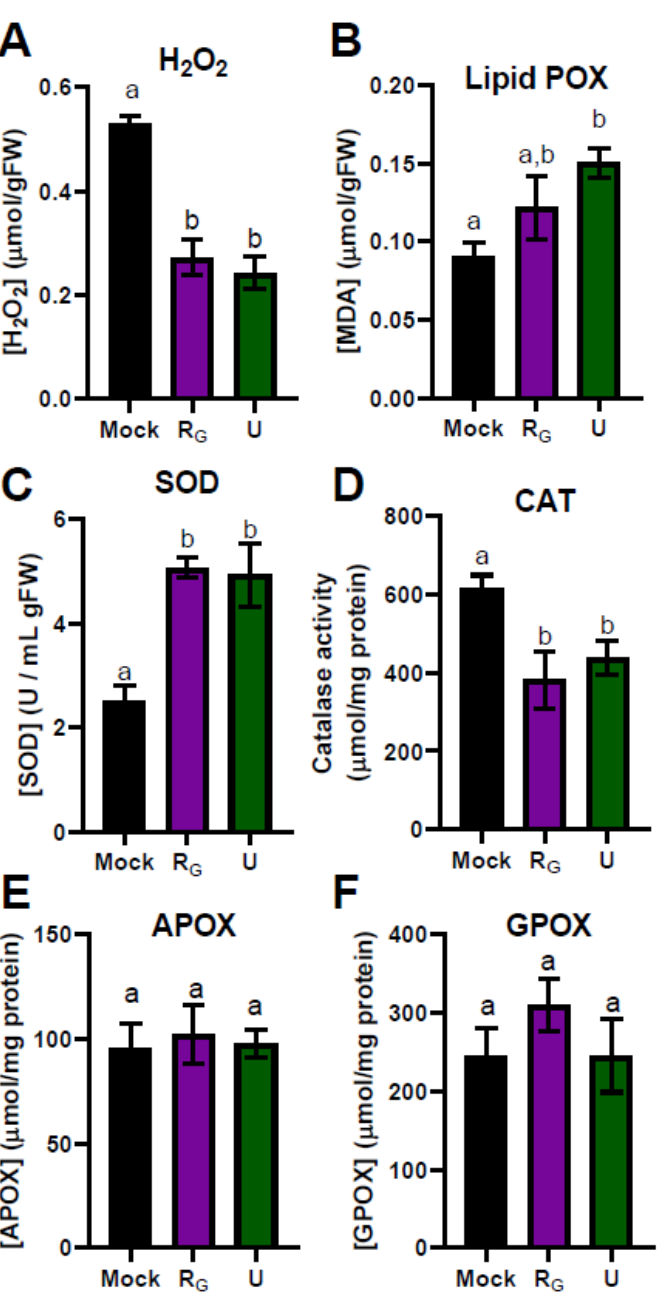
Figure 4. Total H 2 O 2 ( A ); lipid peroxidation measured as malonaldehyde (MDA) production ( B ); superoxide dismutase (SOD) ( C ); catalase (CAT) ( D ); ascorbate peroxidase (APOX) ( E ); guaiacol peroxidase (GPOX) ( F ), of non-treated (Mock, black bars) and treated common bean with grapevine pomace (R G , purple bars) and nettle (U, green bars). Data shown are the mean ± SE of three independent experiments. Statistically significant differences were analyzed by means of one-way ANOVA with a Tukey post hoc test ( p < 0.05).